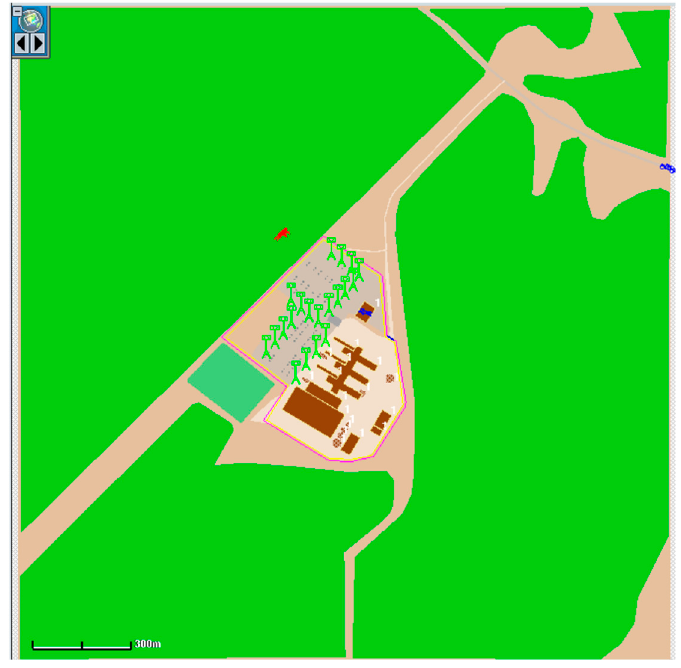
Figure 1. Baseline Model of Substation in JCATS, LLNL-PRES-746039.